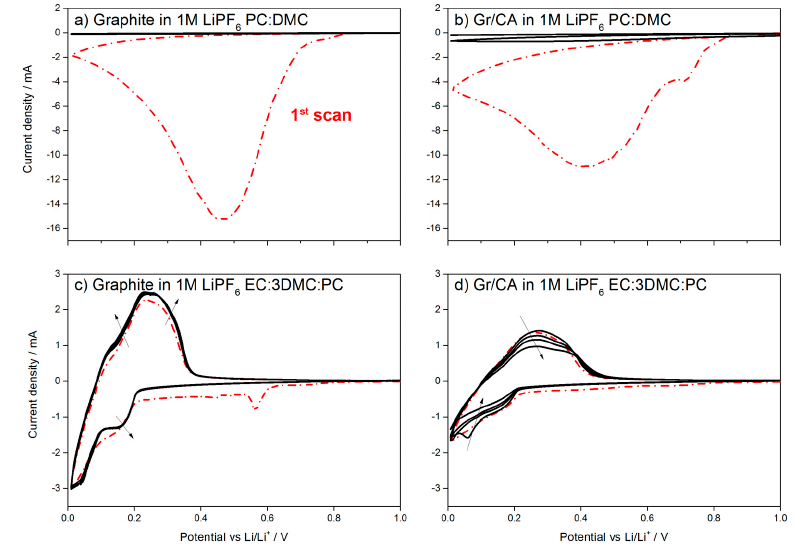
Figure 7. Cyclic voltammetry (CV) of pristine and carbon-coated (5 wt% of carbon from citric acid) graphite samples in 1M LiPF 6 PC:DMC electrolyte (panels a and b ) and in EC:3DMC:PC 1M LiPF 6 electrolyte (panels c and d ). The arrows indicate the cycle increment. PC: propylene carbonate, DMC: dimethyl carbonate, EC: ethylene carbonate. Electrode area: 1.13 cm². Scan rate: 0.1 mV s − 1 .